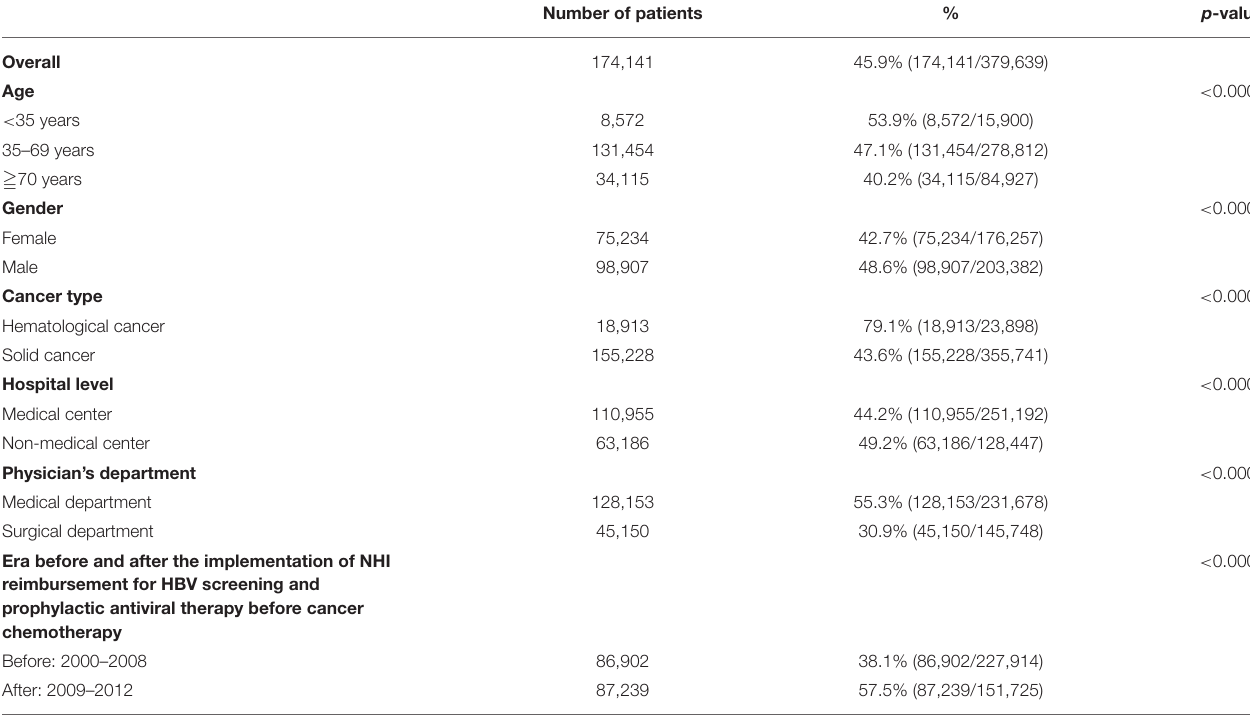
TABLE 2 | HBV screening rates in whole patients and subgroup analyses.